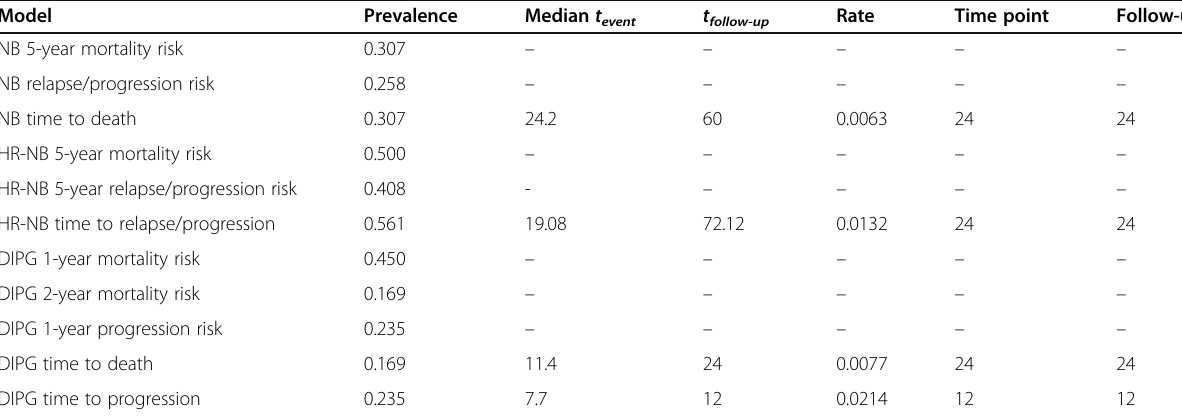
Table 2 Required data for sample size calculations